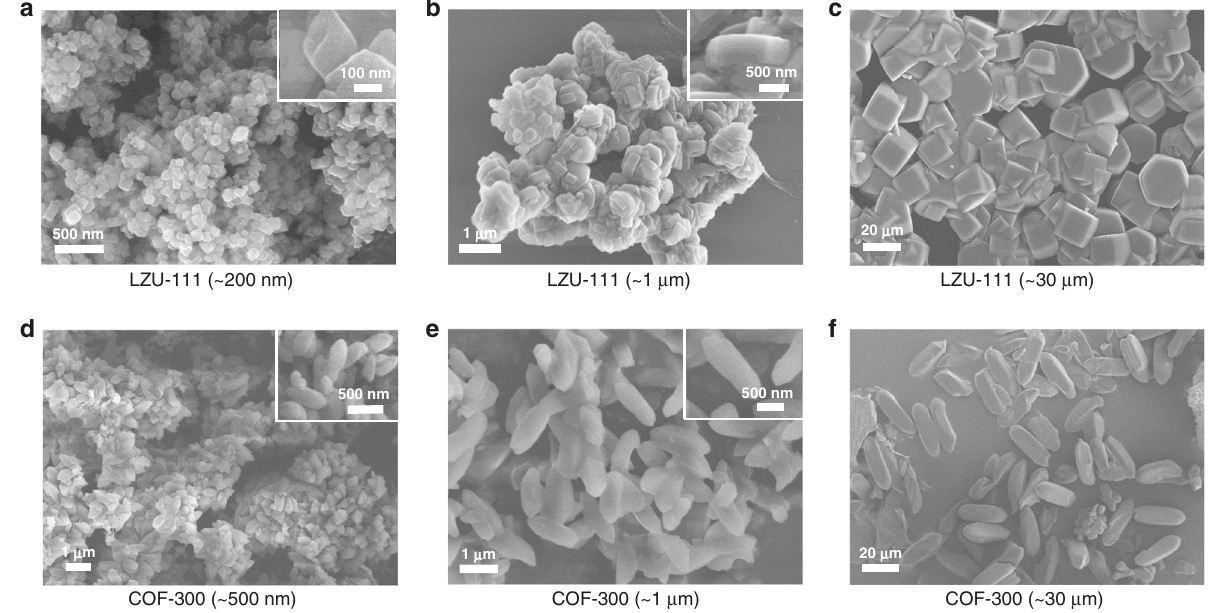
Fig. 2 Scanning electron microscopy (SEM) images of different-sized LZU-111 and COF-300 crystals. a – c SEM images of LZU-111 crystals with the average sizes of ~200 nm, ~1, and ~ 30 µ m, respectively. d – f SEM images of COF-300 crystals with the average sizes of ~500 nm, ~1 and ~30 µ m, respectively. For nano-sized and ~1 µ m-sized crystals, the magni fi ed images were inserted for